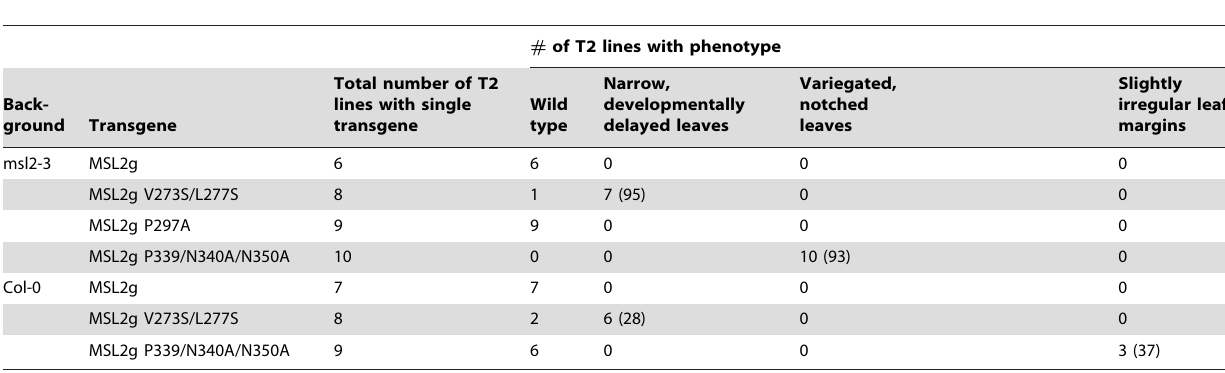
Table 1. Phenotypic characterization of T2 lines expressing MSL2g variants in the msl2-3 and the wild type Columbia (Col-0) backgrounds.